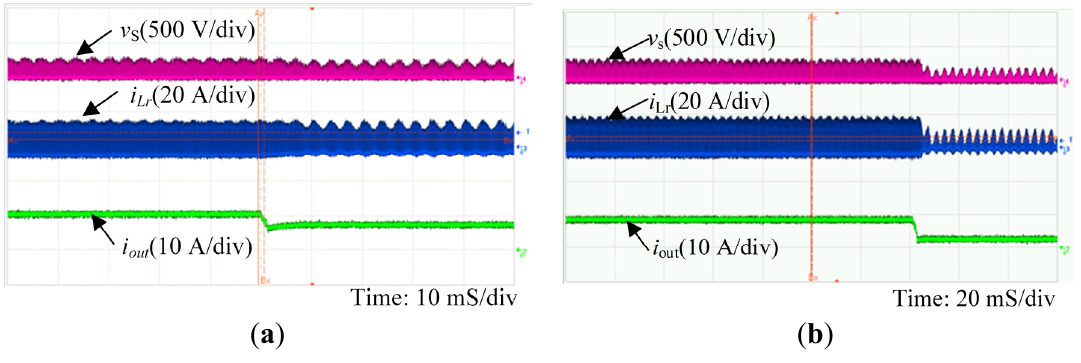
Figure 24. Experimental results under the mode transition point.